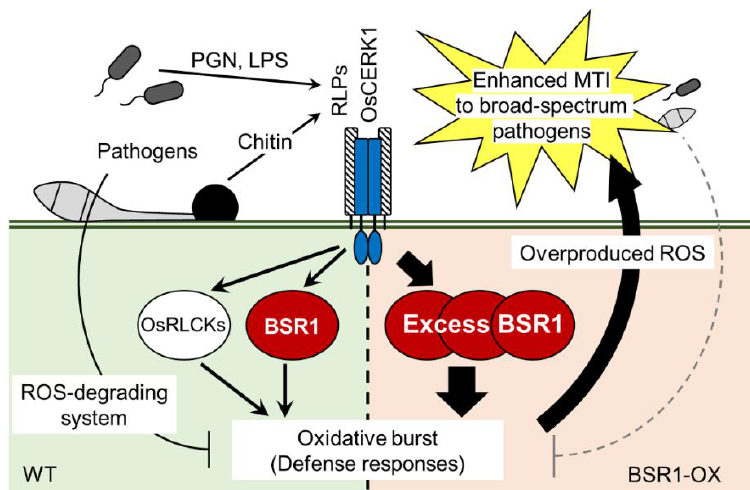
Figure 6. Proposed model in which BSR1 regulates defense responses, such as oxidative bursts, after the perception of MAMPs in wild-type (WT; left ) and BSR1-overexpressing rice lines (BSR1-OX; right ). PGN, peptidoglycan; LPS, lipopolysaccharide; RLPs, receptor-like proteins; ROS, reactive oxygen species; MTI, MAMP-triggered immunity.